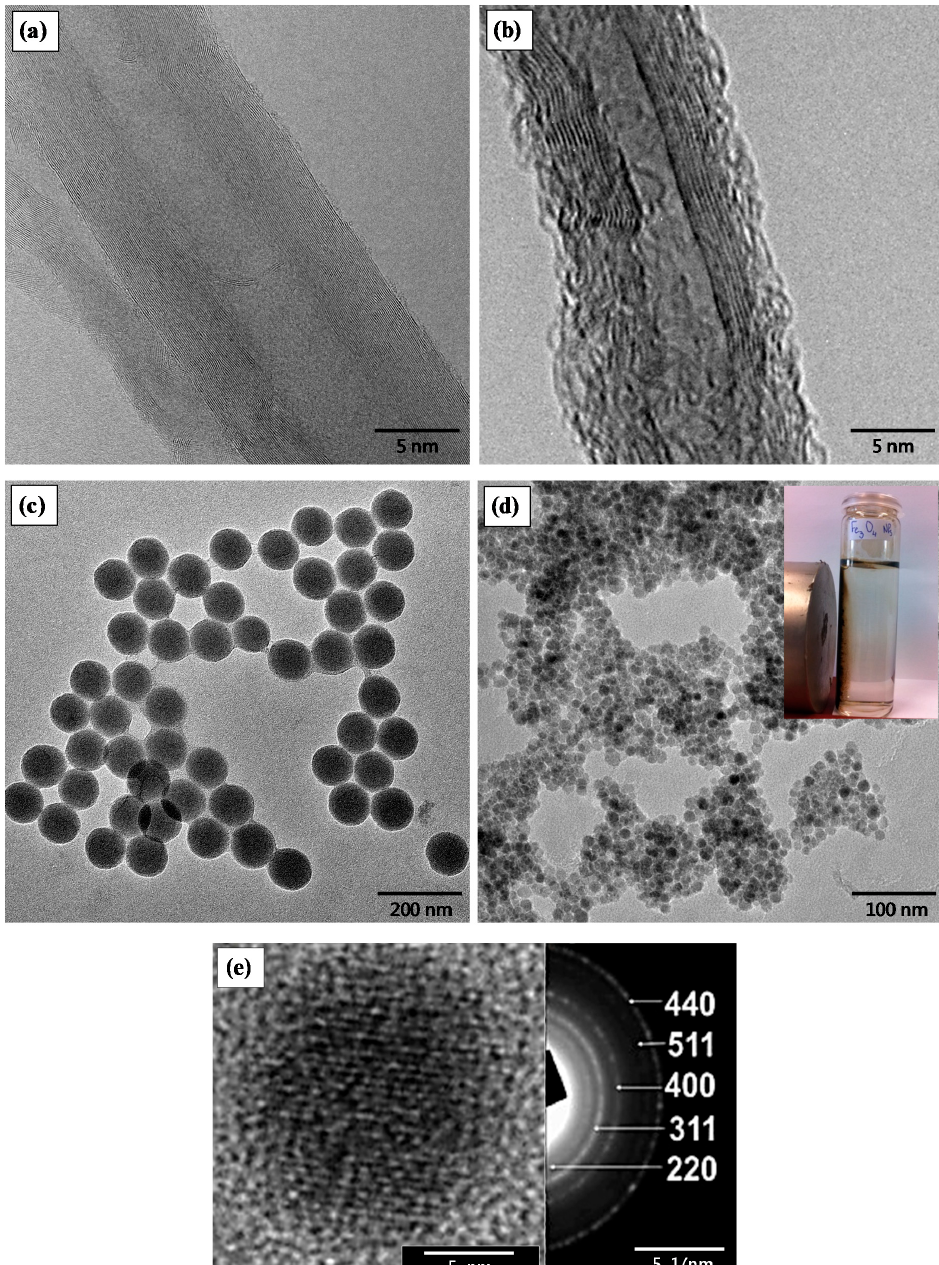
Figure 2. HR-TEM images of ( a ) pristine MWCNT, ( b ) functionalised MWCNT-COCl, ( c ) PEI-modified SiO 2 NPs and ( d ) Fe 3 O 4 SPM magnetite NPs (inset: the response of Fe 3 O 4 NPs to an external magnet within 1 min); ( e ) HR-TEM image and the corresponding selected area electron di ff raction (SAED) pattern of Fe 3 O 4